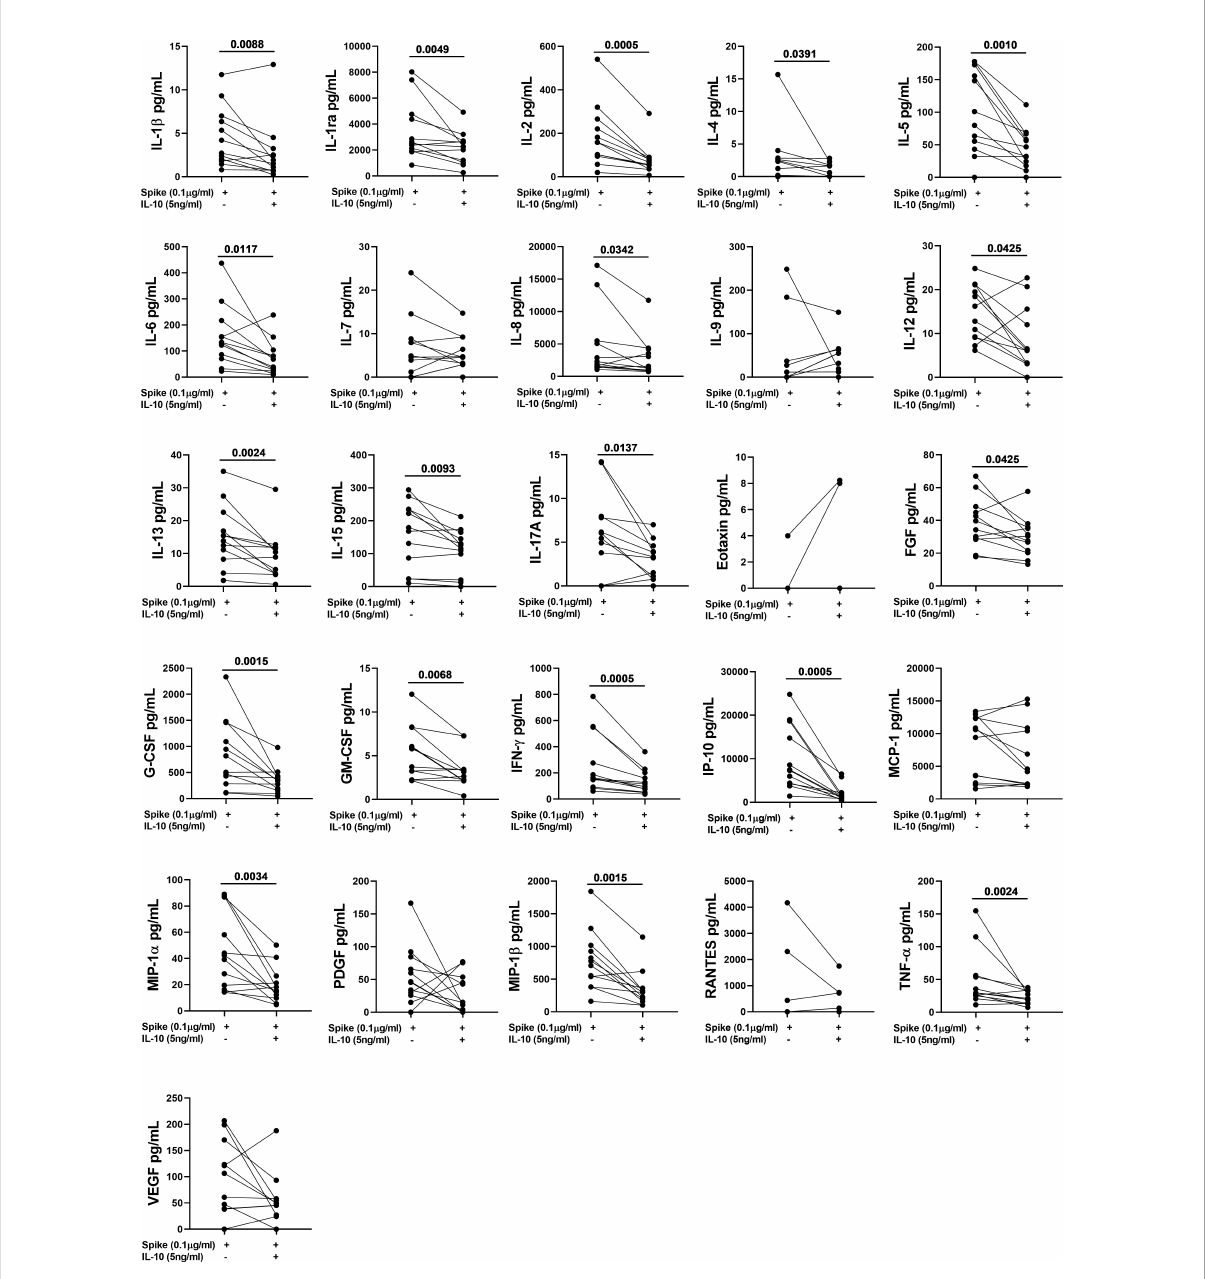
FIGURE 5 IL-10 signi fi cantly downregulates several Spike-induced cytokines, chemokines, and growth factors in NO COVID-19-Vaccinated Controls (NO COVID-19-VC) of study population “ B ” . Whole-blood was stimulated or not with a pool of Spike peptides (Pool S) of SARS-COV-2 and then treated or not with IL-10. After overnight stimulation, plasma was collected and used to detect immune factors by a 27-plex multiplex assay